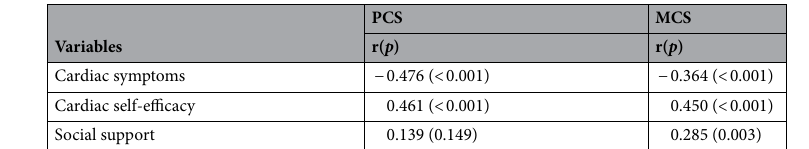
Table 4. Correlations between cardiac symptoms, cardiac self-efficacy, social support, and health-related Quality of Life (N = 110). PCS physical component summary, MCS mental component